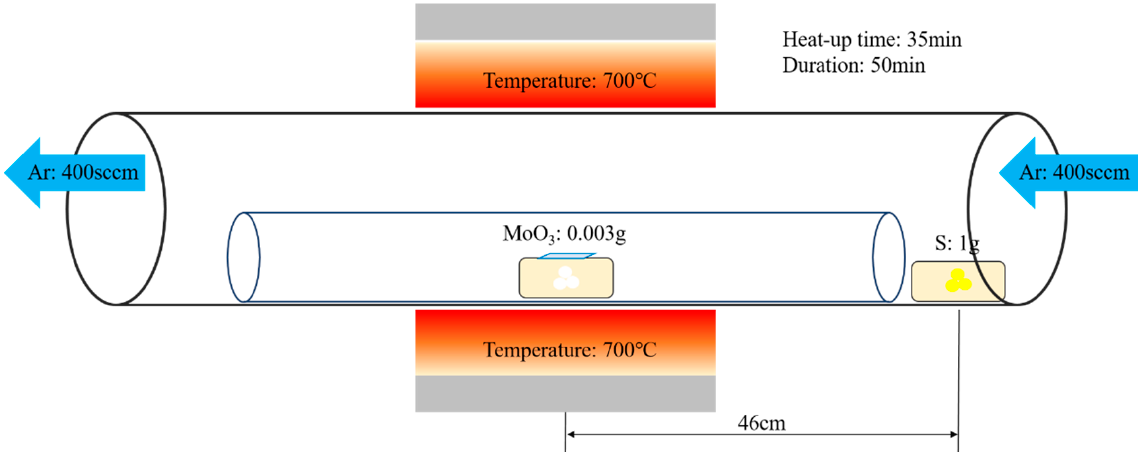
Figure 1. Flow chart of MoS 2 growth by CVD.